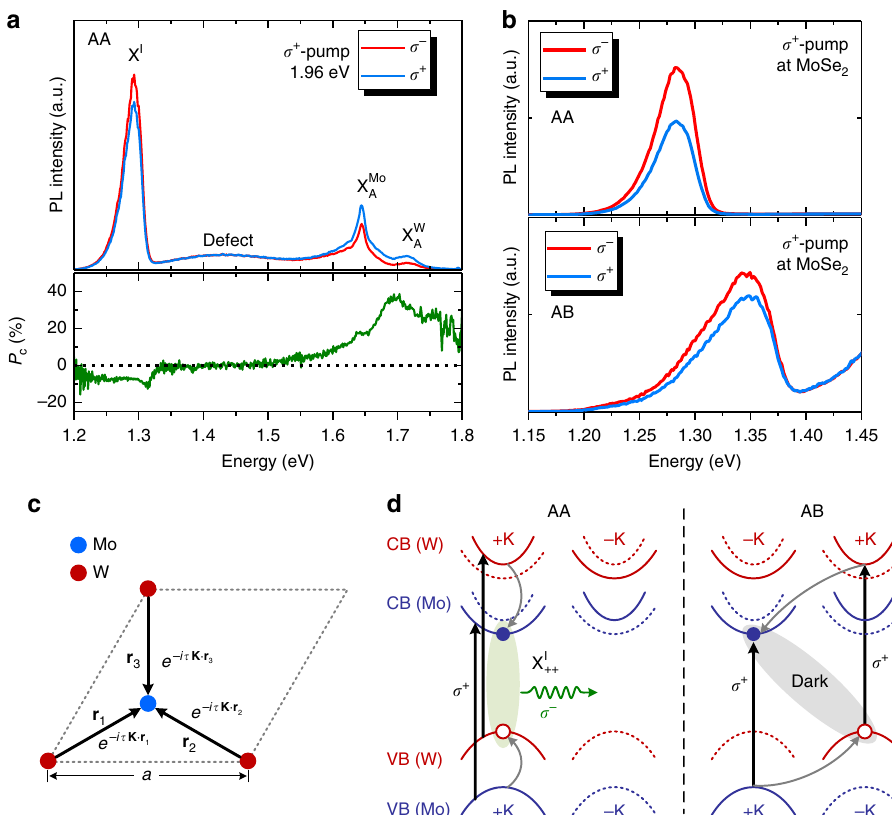
Fig. 3 Valley polarization of interlayer excitons. a Top: polarization-resolved PL spectra for the AA-stacked hBL using σ + excitation at 1.96 eV. Bottom: the degree of circular polarization P C . b Polarization-resolved PL spectra near the X I peak using σ + excitation at 1.64 eV (MoSe 2 ) in AA- (top) and AB- (bottom) stacked hBLs. c The atomic registries and the phases associated with the interlayer transition dipoles in AA and AB stacking. A distinct phase factor e i τ K (cid:4) r n is associated with each interlayer transition dipoles between the nearest Mo and W atoms in different layers. d Left: the formation of X I þþ state in AA-stacked hBLs using σ + excitations at + K valleys in MoSe 2 and WSe 2 layers. Right: the formation of the interlayer dark state in AB-stacked hBLs using σ + excitations at both MoSe 2 and WSe 2 layers. Red and blue lines are WSe 2 and MoSe 2 bands, respectively. Solid and dotted lines represent bands with different spins. Vertical arrows indicate optical excitations. Gray arrows represent spin-conserving interlayer transfer to the lowest energy